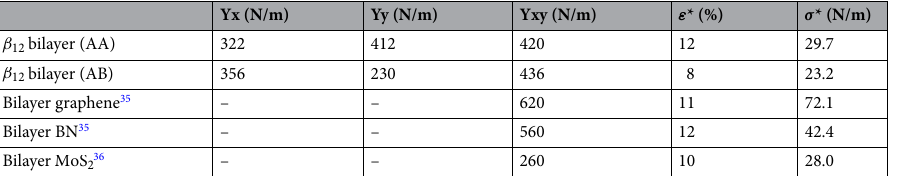
Table 3. Mechanical properties of AA and AB-stacked bilayer borophene, compared with other 2D bilayers including graphene, BN, and MoS 2 : Young’s moduli ( Y ii ), critical strain ( ε *), and ultimate strength ( σ